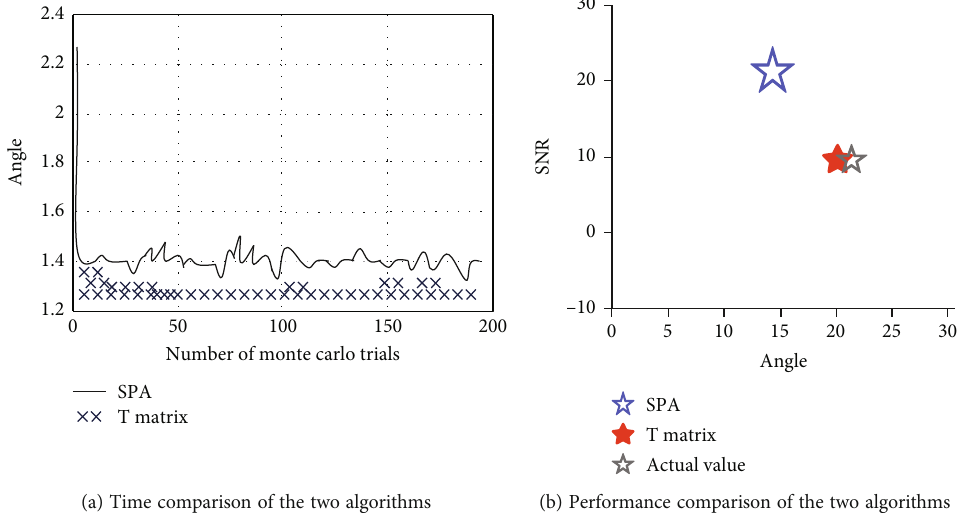
Figure 9: Comparison of running time and DOA accuracy between T-matrix reconstruction algorithm and SPA